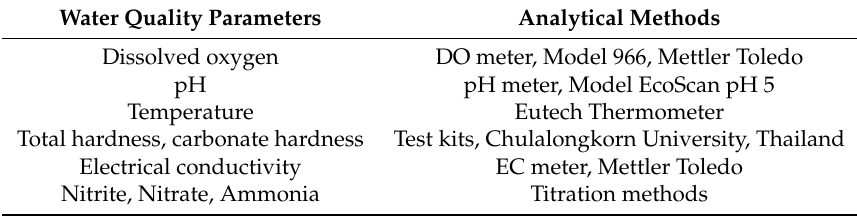
Table 1. Analytical methods used for measurements of water quality parameters.